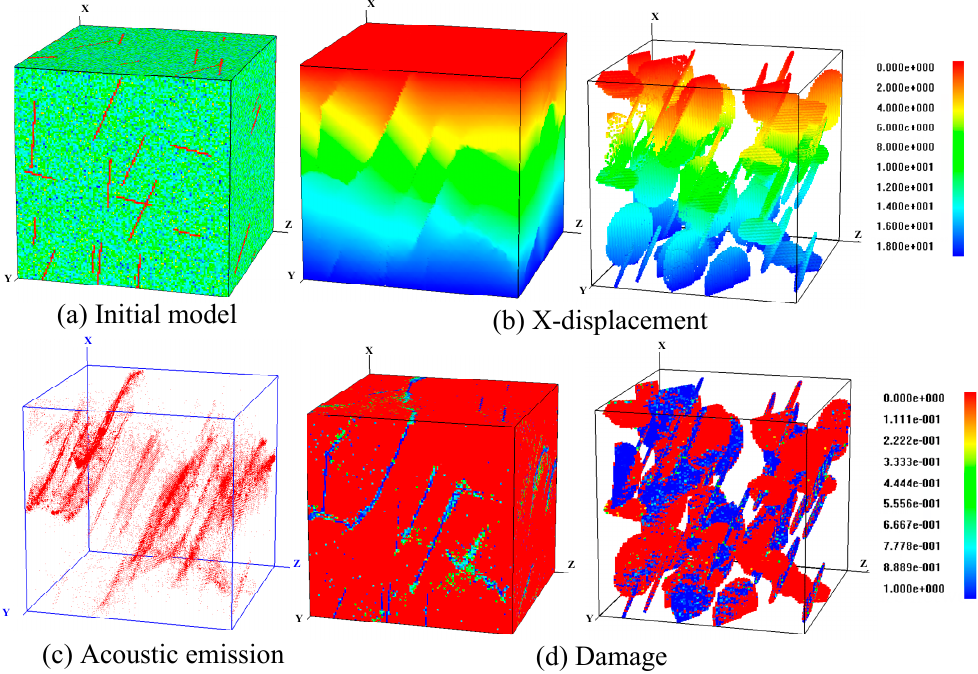
Figure 5. The deformation characteristics and failure pattern for T-1.